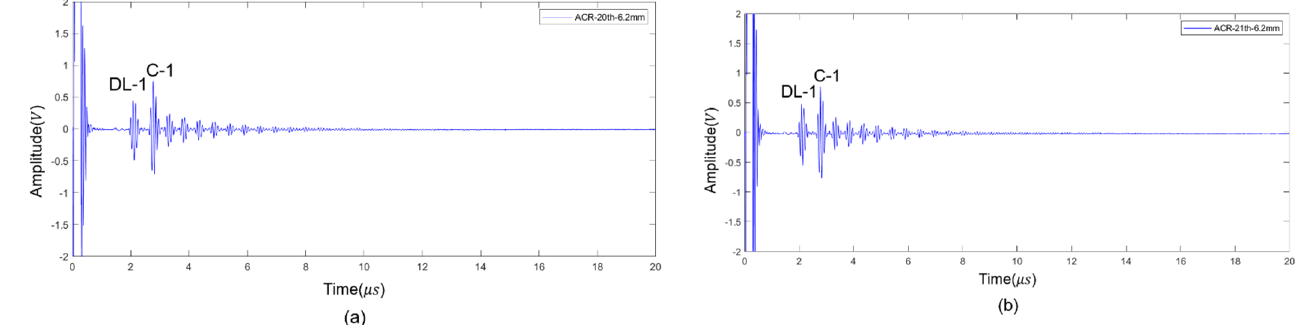
Figure 6. Experiment results. Measure the thickness of the coating material with acrylic delay lines of 6.2 mm ( a ) In the 20th area, ( b ) In the 21st area. Table 3. Coating thickness measurements by caliper and ultrasound at 20th area.